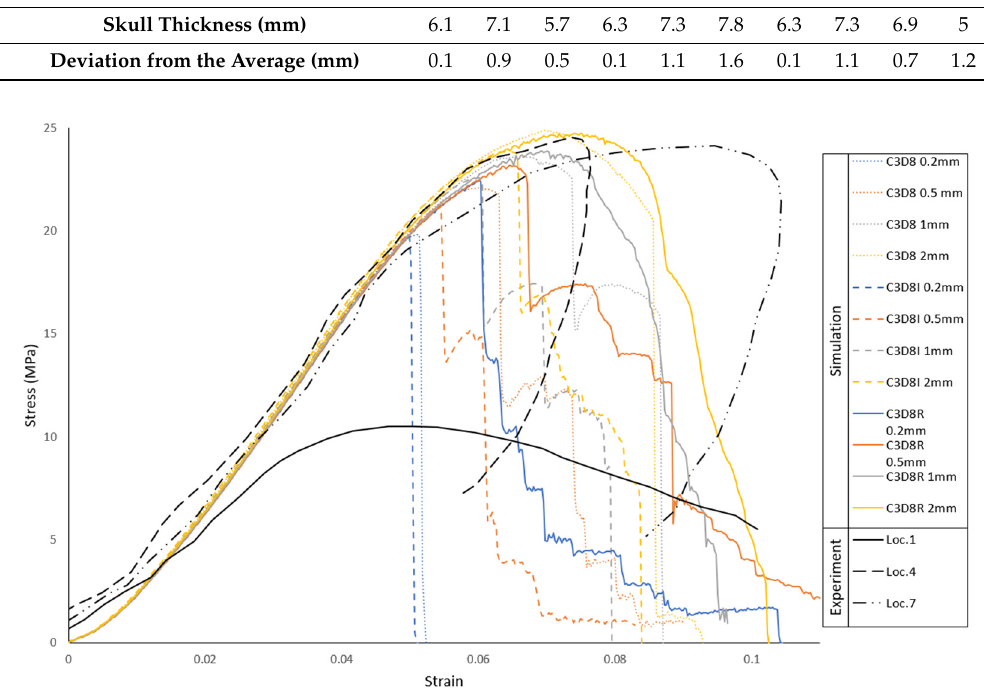
Figure 9. Element type and mesh density results in comparison with the experiments for three locations.